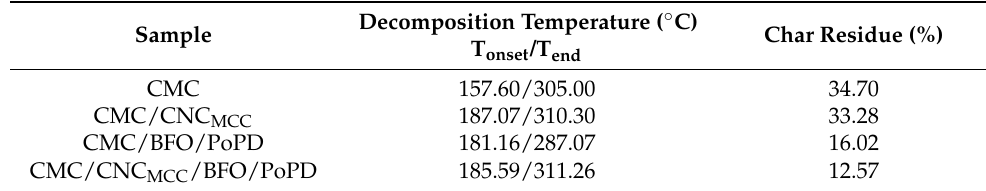
Figure 2. ATR-FTIR spectrum of (a) CMC, (b) CMC/CNC MCC , (c) CMC/BFO/PoPD, and (d) CMC/CNC MCC /BFO/PoPD composite film. Table 1. Thermogravimetric analysis of CMC film, CMC/CNC MCC film, CMC/BFO/PoPD composite film, and CMC/CNC MCC /BFO/PoPD composite